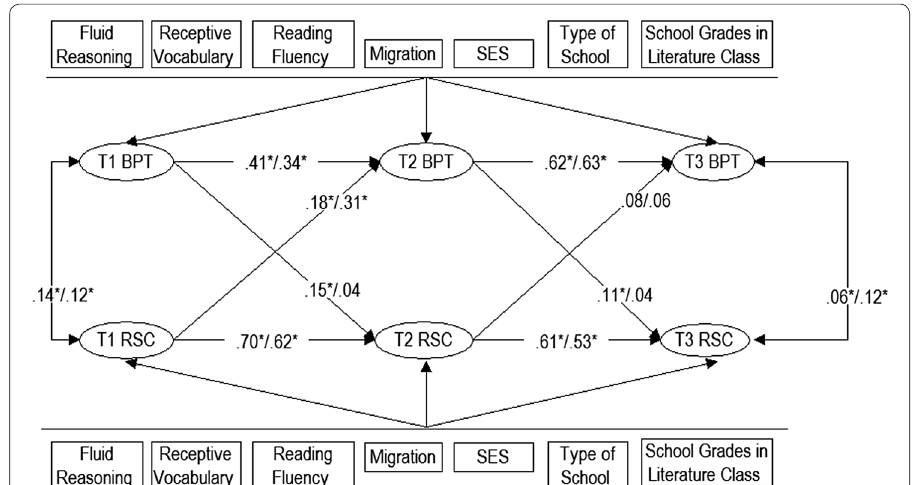
Fig. 2 Study 2: Model scheme of the structure equation model with cross-lags outlined over the measurement points T1 Time 1, T2 Time 2 and T3 Time 3. Girls’ (before the slash)/boys’ (after the slash) = = = ASC academic self-concept (Fischer et al. 2017 and BPT belief about one’s own perspective-taking (Davis = = 1980) were specified as latent variables (indicators and residuals are not depicted). Relevant factors were included as manifest variables, i.e., fluid reasoning and receptive vocabulary (Weiß 2006), reading fluency (Auer et al. 2011), migration ethnic background (out of Germany coded as 1, German background coded as = 0), SES socio-economic status, type of school, and school grades in literature class. * p < =